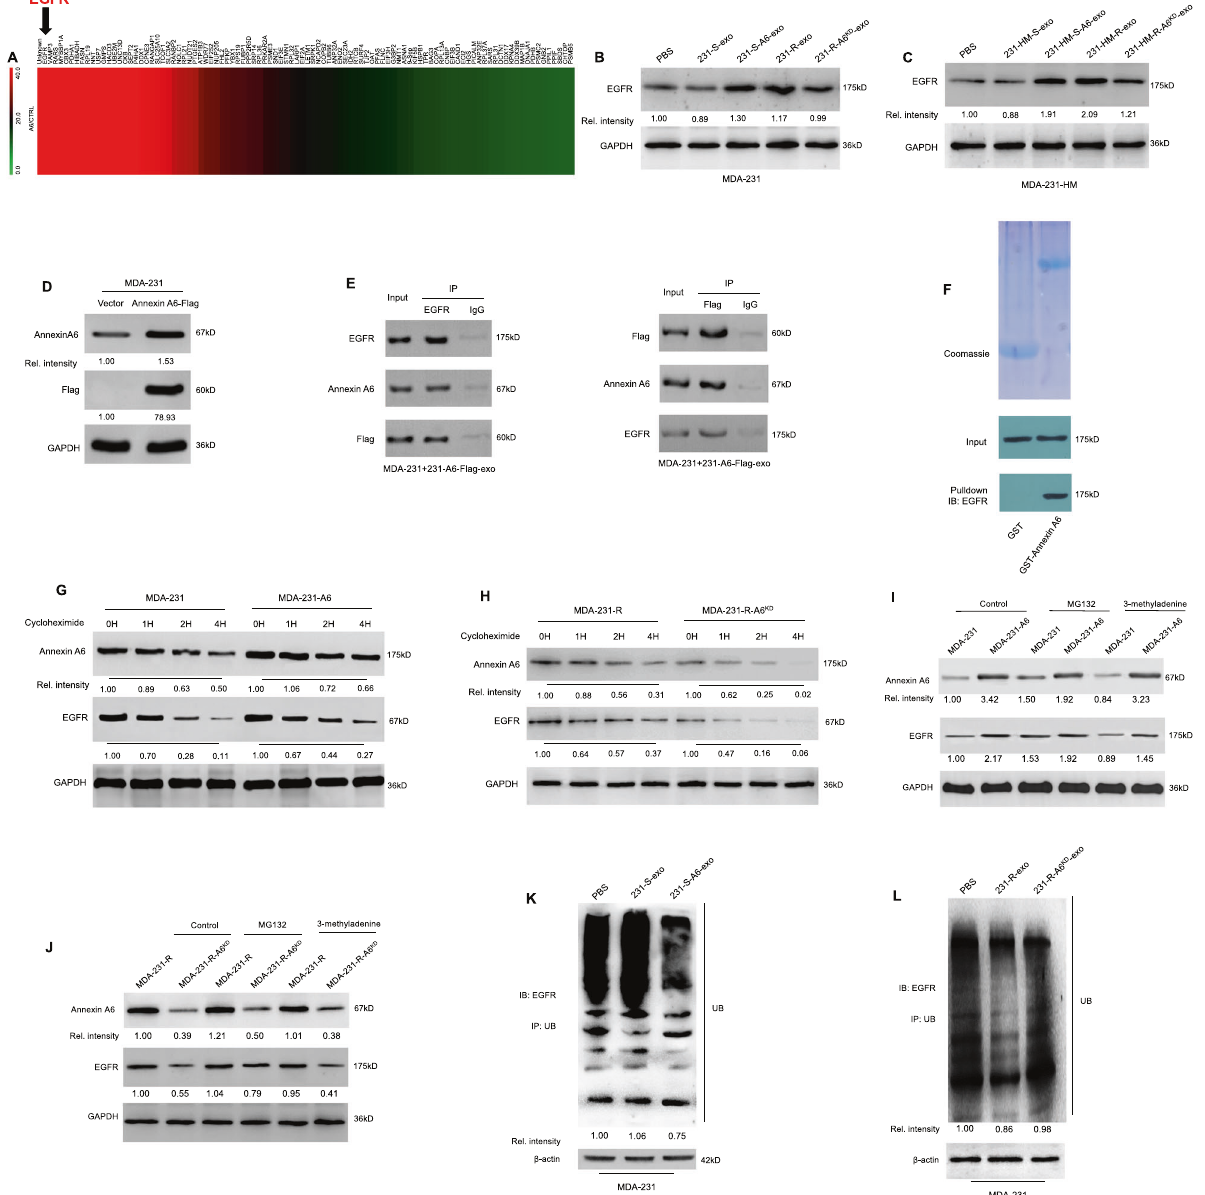
Fig. 5 The interaction of ANXA6 and EGFR inhibit EGFR ubiquitination and degradation. A Mass spectrographic analysis revealed the different gene expression patterns between MDA-231 cells treated with 231-S-exo and 231-S-A6-exo. The second most strongly upregulated gene was EGFR. B EGFR was upregulated in MDA-231 cells treated with 231-S-A6-exo and 231-R-exo. EGFR was downregulated in MDA-231 cells treated with 231-R-A6 KD -exo when compared with MDA-231 cells treated with 231-R-exo. C EGFR was upregulated in MDA-231-HM cells treated with 231-HM-S-A6-exo and 231-HM-R-exo. EGFR was downregulated in MDA-231-HM cells treated with 231-HM-R-A6 KD -exo when compared with MDA-231-HM cells treated with 231-HM-R-exo. D ANXA6-Flag was overexpressed in stably transfected MDA-231 cells (MDA- 231-A6-Flag). E Co-immunoprecipitation (IP) was performed using an IgG antibody control or antibodies against ANXA6, Flag, or EGFR on lysates from MDA-231 cells treated with MDA-231-A6-Flag cell-derived exosomes (231-A6-Flag-exo). IP products with IgG and speci fi c antibodies were resolved via western blotting and probed for ANXA6, Flag, and EGFR. F The expression of GST and GST-Annexin A6 were examined with Coomassie blue staining (top). GST pulldown assays with GST or GST-Annexin A6 puri fi ed from E. coli and in vitro translated EGFR. EGFR interacted with GST-Annexin A6 as detected by EGFR Western blot (bottom). G , H The expression levels of EGFR and ANXA6 were examined by western blotting in MDA-231, MDA-231-A6, MDA-231-R, and MDA-231-R-A6 KD cells treated with 15 µg/ml cycloheximide for 0, 1, 2, or 4 h. I , J The expression levels of ANXA6 and EGFR were examined by western blotting in MDA-231, MDA-231-A6, MDA-231-R, and MDA- 231-R-A6 KD cells treated with the proteasome inhibitor MG132 (20 µM) and autophagy inhibitor 3-methyladenine (10 mmol/l) for 24 h. K , L Ubiquitination assay detected the inhibition of EGFR ubiquitination and degradation in MDA-231 cells treated with PBS, 231-S-exo and 231-S-A6-exo or PBS, 231-R-exo and 231-R-A6 KD -exo. All experiments were repeated three times, and the representative results are presented.